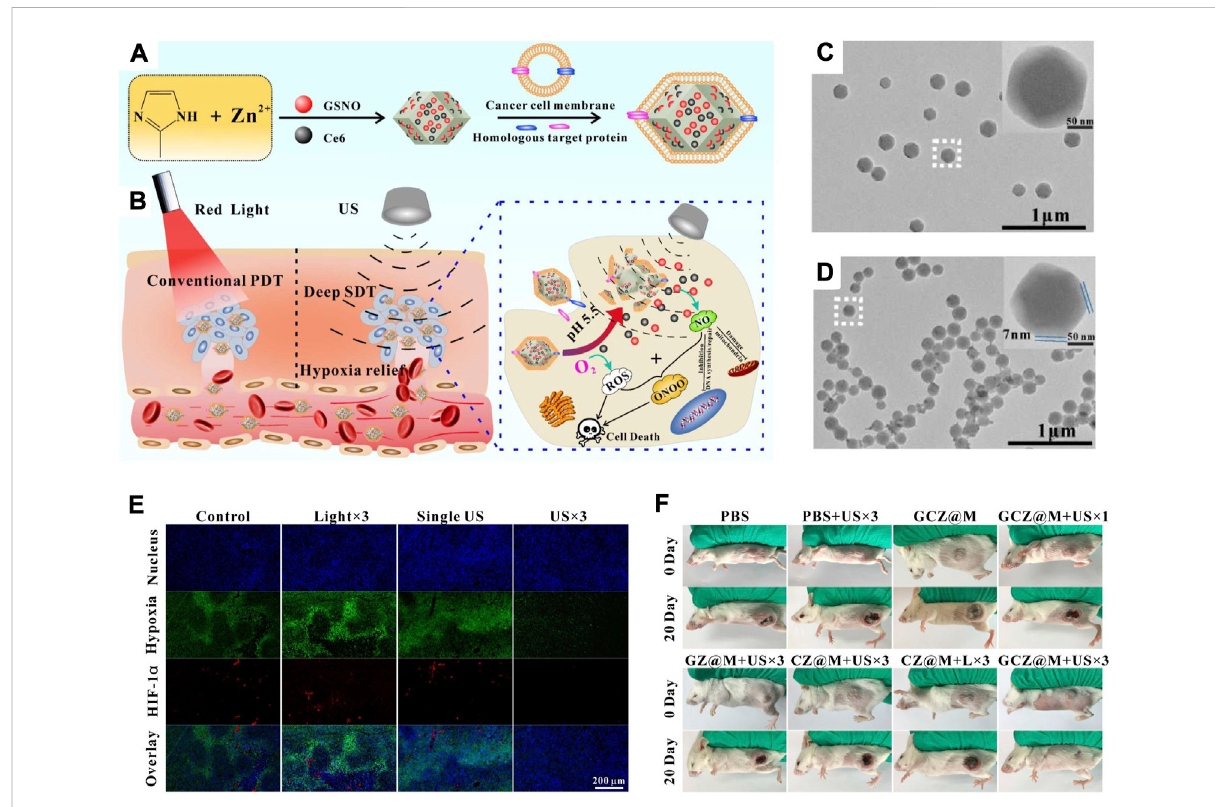
FIGURE 7 (A) Schematic illustration of the synthesis process of GCZ@M. (B) Schematic illustration of the tumor therapy principle. (C,D) TEM and magni fi cationimages(inset)ofGCZ (C) andGCZ@M (D) . (E) Immuno fl uorescenceanalysisoftumorsectionsafterindicatedtreatments. (F) Photosof tumor-bearing mice after indicated treatments. Reprocessed with permission from ref 71. Copyright 2019, Elsevier Ltd. All rights